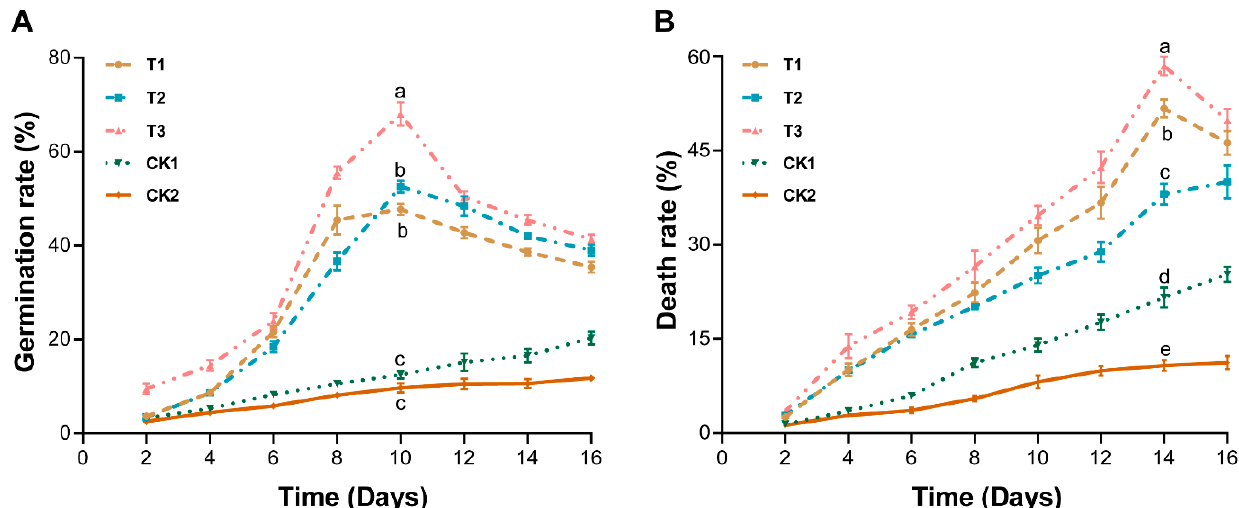
Figure 2. Effect of marigold root exudates, crude extract, and powder on the germination and death of Plasmodiophora brassicae resting spores after specific days of treatment. Germination ( A ) and death ( B ) rate of P. brassicae resting spore under different treatments. Here; Marigold root exudates (T1), crude extract (T2), powder (T3), methanol (CK1), and sdH 2 O (CK2). Different lowercase letters on the error bars show significant differences among treatments according to Duncan’s multiple range test at p < 0.05.